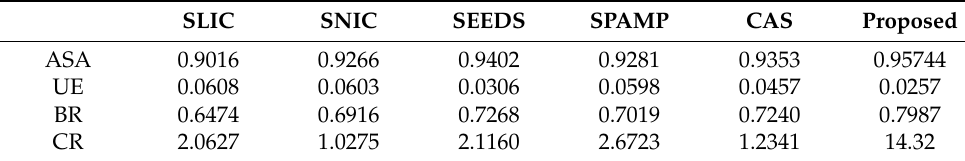
Table 3. Segmentation metrics of the real SAR image by four methods.